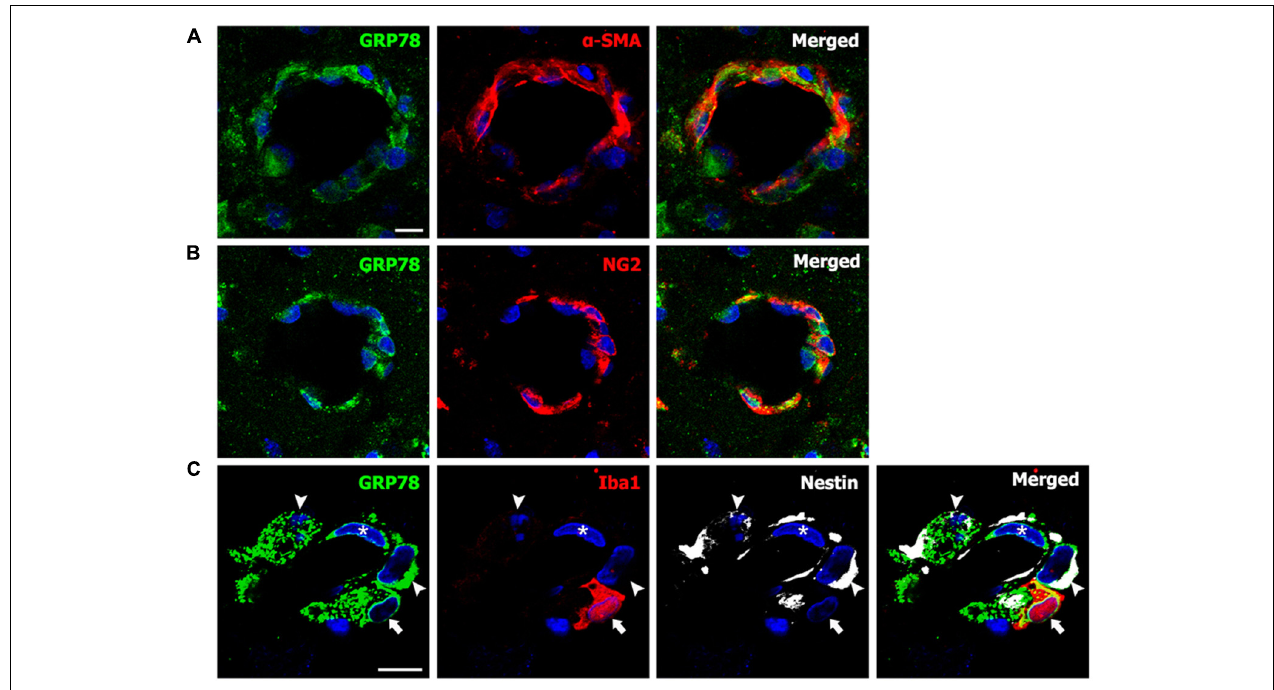
FIGURE 7 | Phenotypic characterization of vessel-associated glucose-regulated protein (GRP78)-positive cells in the lesion periphery on day 3 after lesion induction by 3-nitropropionic acid injection. (A,B) Double-labeling of GRP78 and two smooth muscle cell markers, alpha-smooth muscle actin ( α -SMA) and NG2, showing that prominent GRP78 immunoreactivity is visible in smooth muscle cells. (C) Triple-labeling of GRP78, Iba1, and nestin showing that GRP78 expression can be detected in endothelial cells (asterisks), Iba1-positive microglia/macrophages (arrows), and nestin-positive perivascular cells (arrowheads). Cell nuclei are stained with 4 (cid:48) ,6-diamidino-2-phenylindole. Scale bars represent 10 µ m for A–C